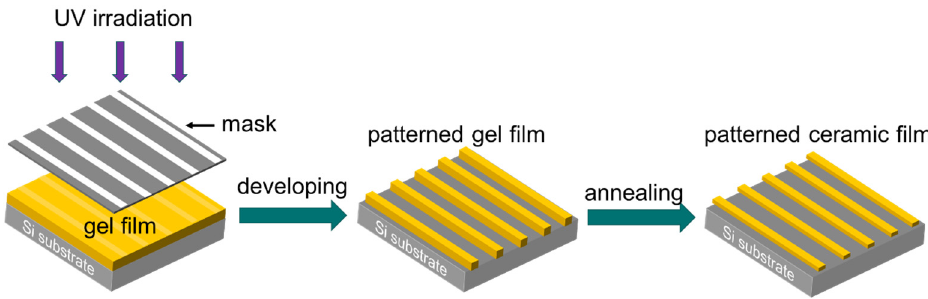
Figure 1. Schematic diagram of preparation process for patterned VO 2 ceramic film.